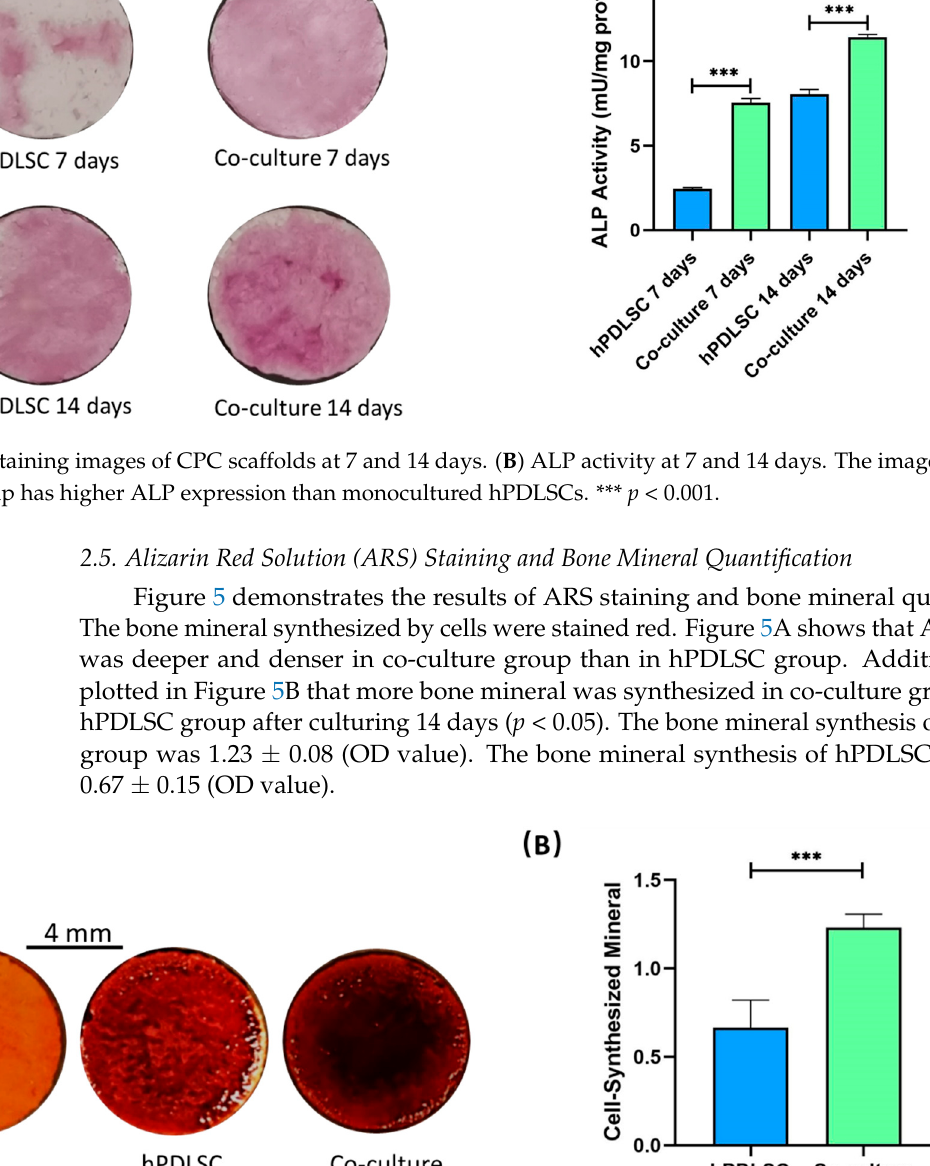
Figure 3. qRT-PCR assay of osteogenic and angiogenic genes at 1, 7, and 14 days: ( A ) VEGF, ( B ) α -SMA, ( C ) vWF, ( D ) ALP, ( E ) Runx- 2, and ( F ) Coll-1. Co-cultured cells had higher angiogenic gene expression (VEGF and α -SMA) than monocultured hUVECs and hPDLSCs. The vWF expression of co-cultured cells was weaker than monocultured hUVECs. Additionally, the osteogenic gene ex- pression (ALP, Runx-2 and Coll-1) of co-culture group was higher than monocultured hPDLSCs. *** p < 0 . 001.